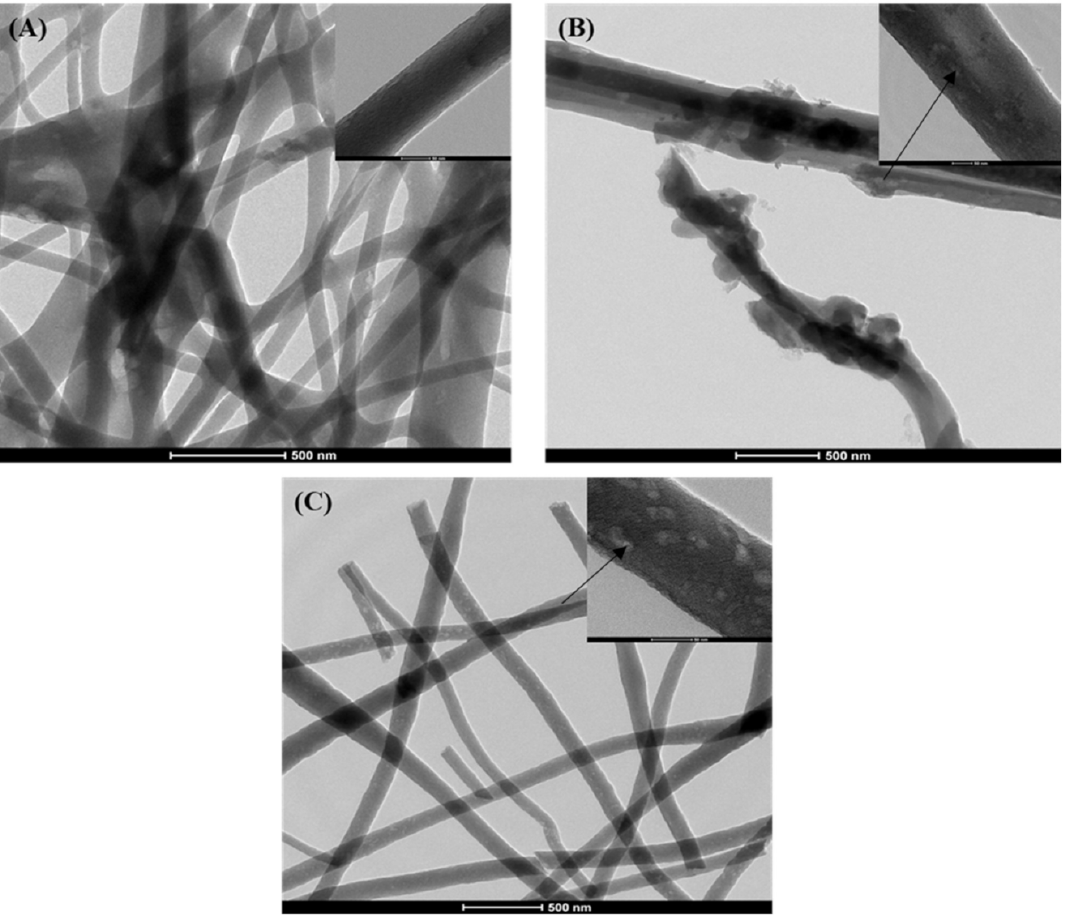
Figure 4. TEM images of the prepared nanofibrous samples (scale bar, 500 nm). ( A ): CNFs, ( B ): CNFs/8HA, and ( C ): CNFs/8HA (hydrothermally).Each image has a highly magnified image in the top-right corner (scale bar, 50 nm). The pointing arrows indicate the HA particles.